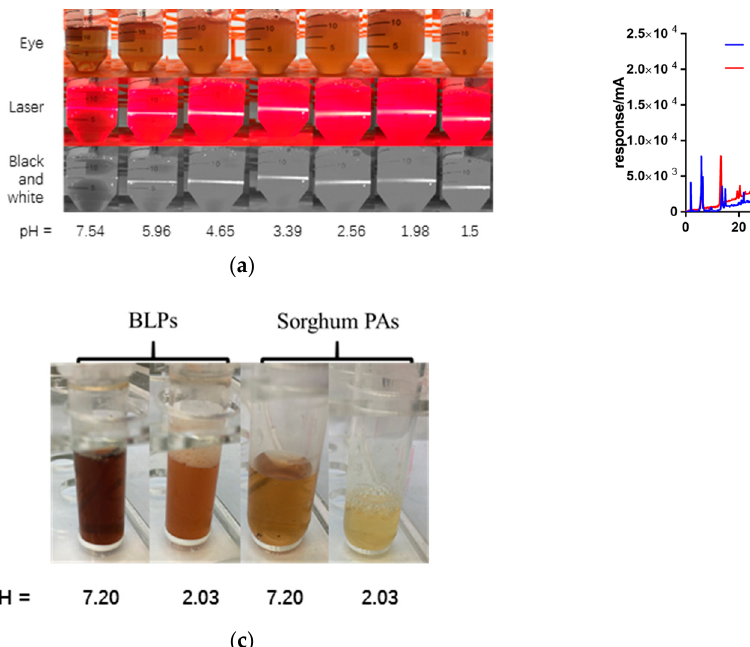
Figure 2. ( a ) BLPs produce sediment under different pH values. ( b ) HPLC of precipitate (PM) and proanthocyanidins (BLPs). ( c ) BLPs and sorghum Proanthocyanidins (Pas) under different pH values.